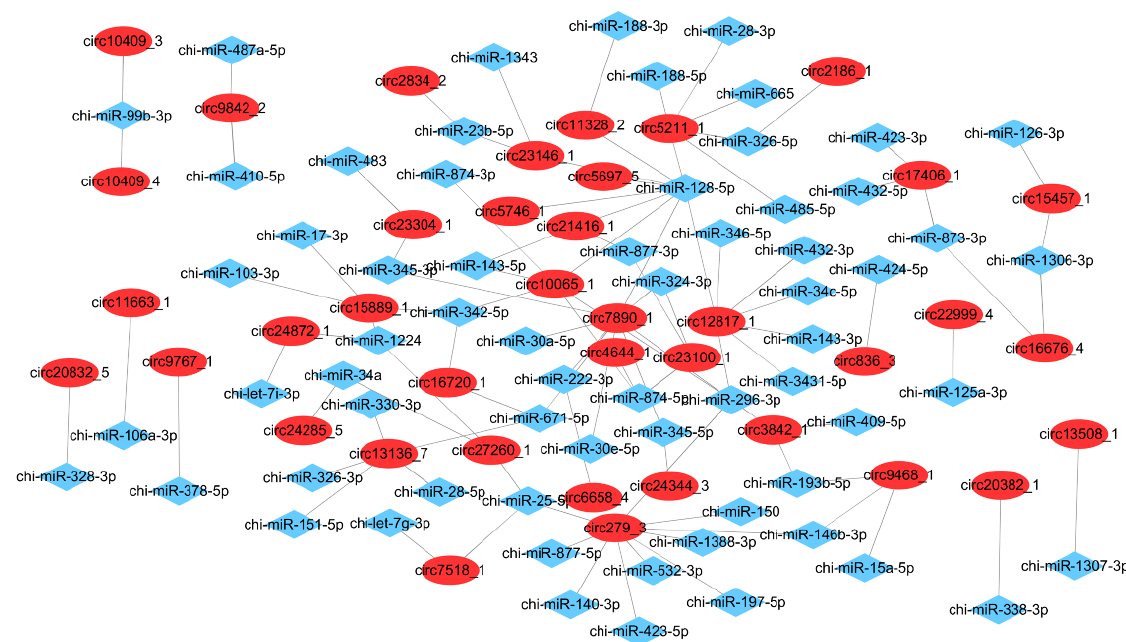
Figure 6. Target miRNA detection of DEcircRNAs. Red ellipses represent DEcircRNAs and blue rhombuses point to miRNA.